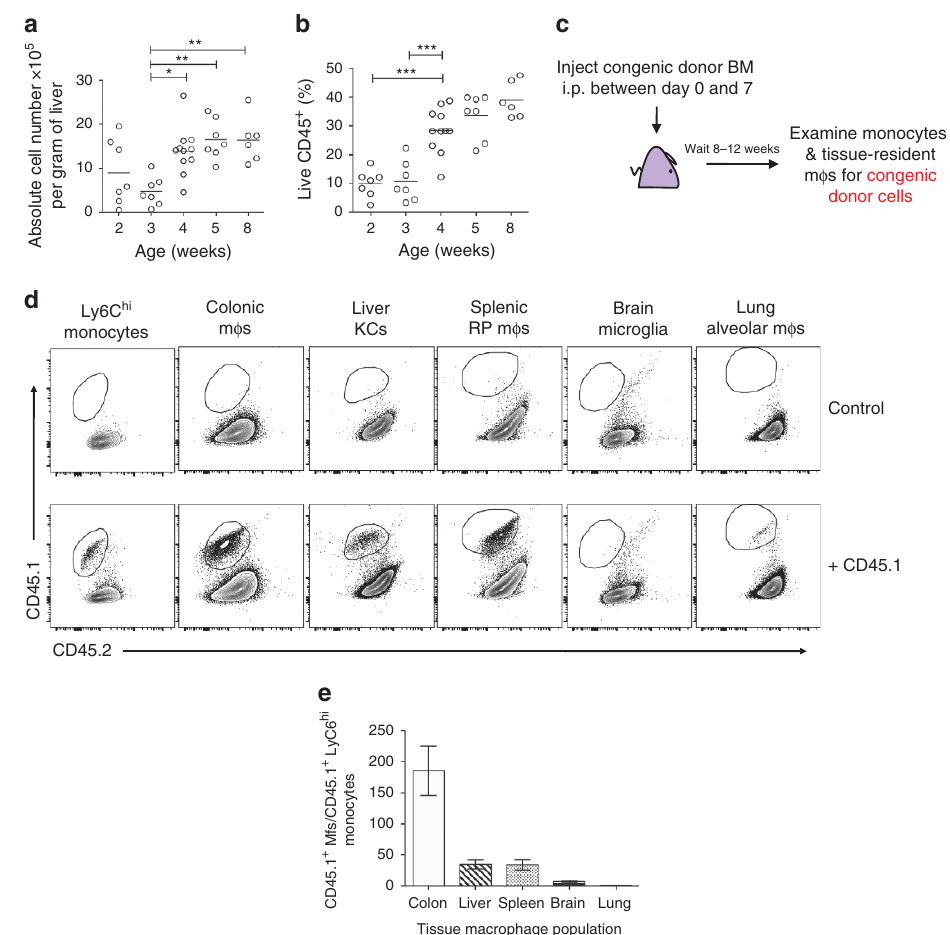
Figure 7 | Mo-KCs are generated during normal liver growth in the first weeks of life. ( a ) Absolute number of KCs per gram of liver at indicated time- points after birth. Data are pooled from two experiments. n ¼ 7 (2, 3 ,5 weeks), 11 (4 weeks) or 6 (8 weeks). * P o 0.05, ** P o 0.01. One way analysis of variance (ANOVA) with Bonferroni post-test. ( b ) Percentage of KCs among live CD45 þ cells at indicated time-points after birth. Data are pooled from two experiments. n ¼ 7 (2, 3, 5 weeks), 11 (4 weeks) or 6 (8 weeks). *** P o 0.001. One way ANOVA with Bonferroni post-test. ( c ) Schematic of adoptive transfer of congenic total BM to newborn pups to assess monocyte contribution to KC pool during growth. Mice were given a single injection of 8 (cid:3) 10 6 BM cells within the first 7 days after birth. ( d ) Representative FACS plots showing engraftment of congenic donor BM into liver Ly6C hi monocytes, colonic macrophages, liver KCs, splenic red pulp macrophages, brain microglia and lung alveolar macrophages, gated as shown in Supplementary Fig. 2. ( e ) Ratio (%) of macrophages derived from CD45.1 congenic BM and Ly6C hi monocytes derived from CD45.1 congenic BM 8–12 weeks post adoptive transfer (i.p.)